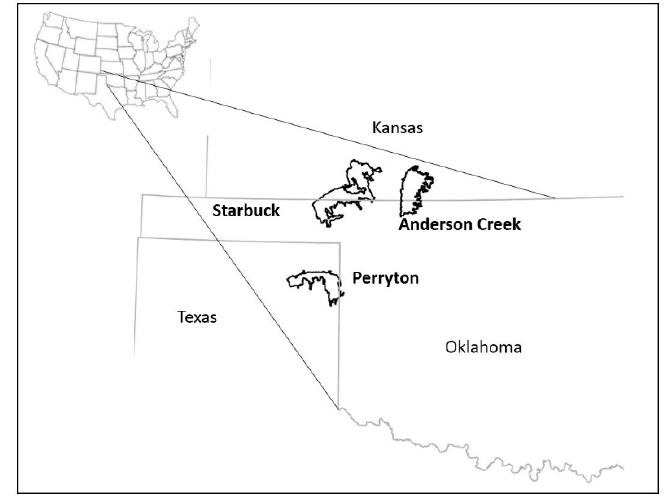
Figure 1. Delineated burned areas for Anderson Creek (2016), Starbuck (2017), and Perryton (2017) wildfires in western Kansas, Oklahoma, and Texas, USA.